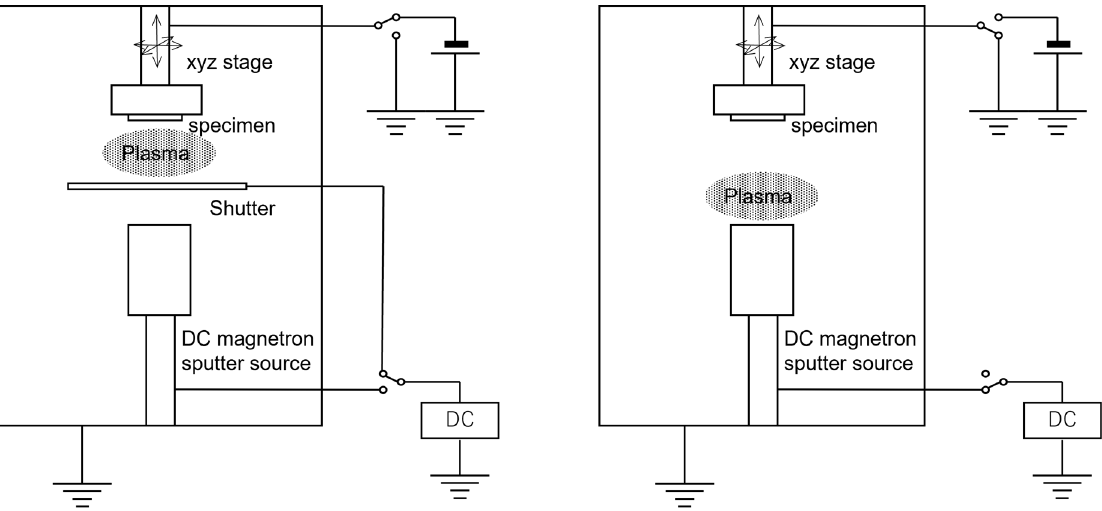
Figure 2. Experimental apparatus. Arrangement for plasma treatment ( a ) and for film deposition ( b ).